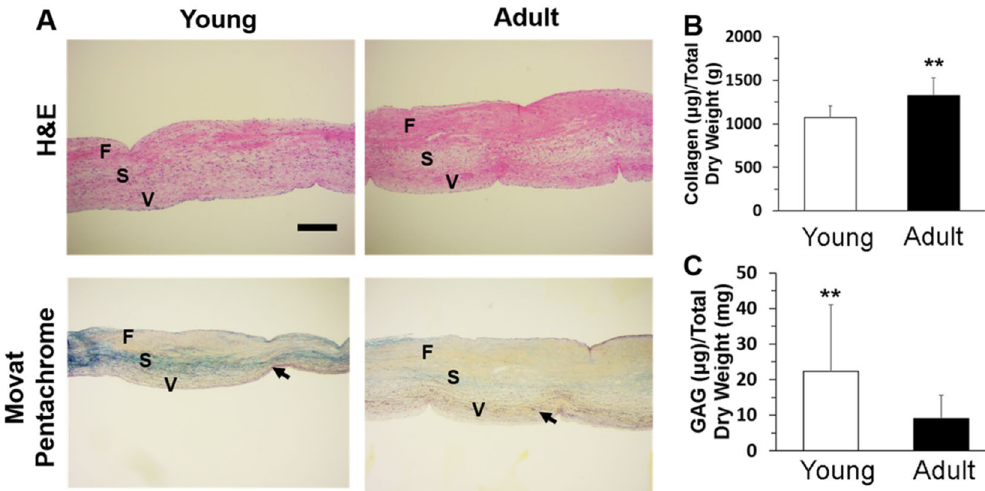
Figure 2. Histological staining and quantitative analysis of ECM components of young and adult PV leaflets. ( A ) H&E and Movat’s pentachrome staining ( F fibrosa, S spongiosa, V ventricularis; arrows indicate elastin fibers); Quantitative analysis of collagen ( B ) and GAGs ( C ) by using hydroxyproline and DMMB assays, respectively (five PV leaflets from 3 different pigs, two pieces from each PV leaflets, **p < 0.01).